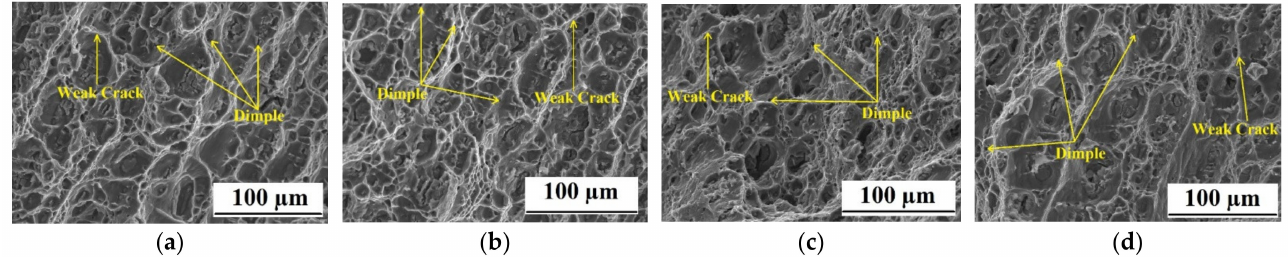
Figure 8. The ambient temperature tensile fracture surfaces of the sample after surface of the 5083 alloy of ( a ) annealed and ECAP after ( b ) 1st pass ( c ) 2nd pass and ( d ) 3rd pass.